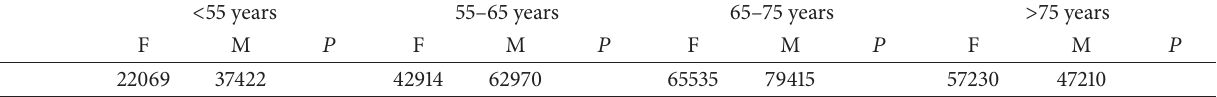
Table 2: Management of LDL-C values in T2DM outpatients according to gender and age.